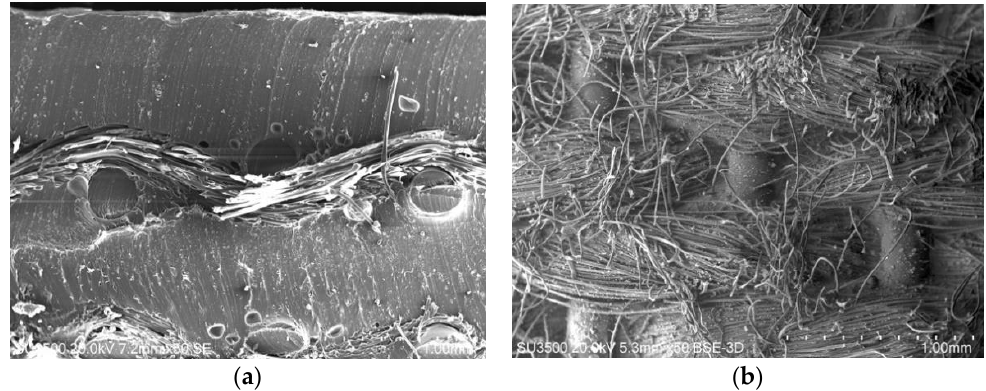
Figure 10. SEM images of: ( a ) cross-section, ( b ) bottom side of material samples for KKA 30-80 test variant.